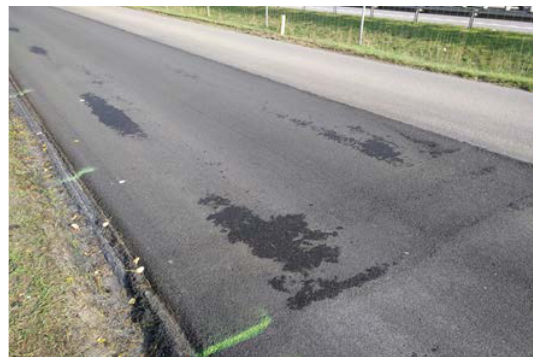
Figure 22. Transvers mark caused by paver stop on the Galaktyczna street trial section.